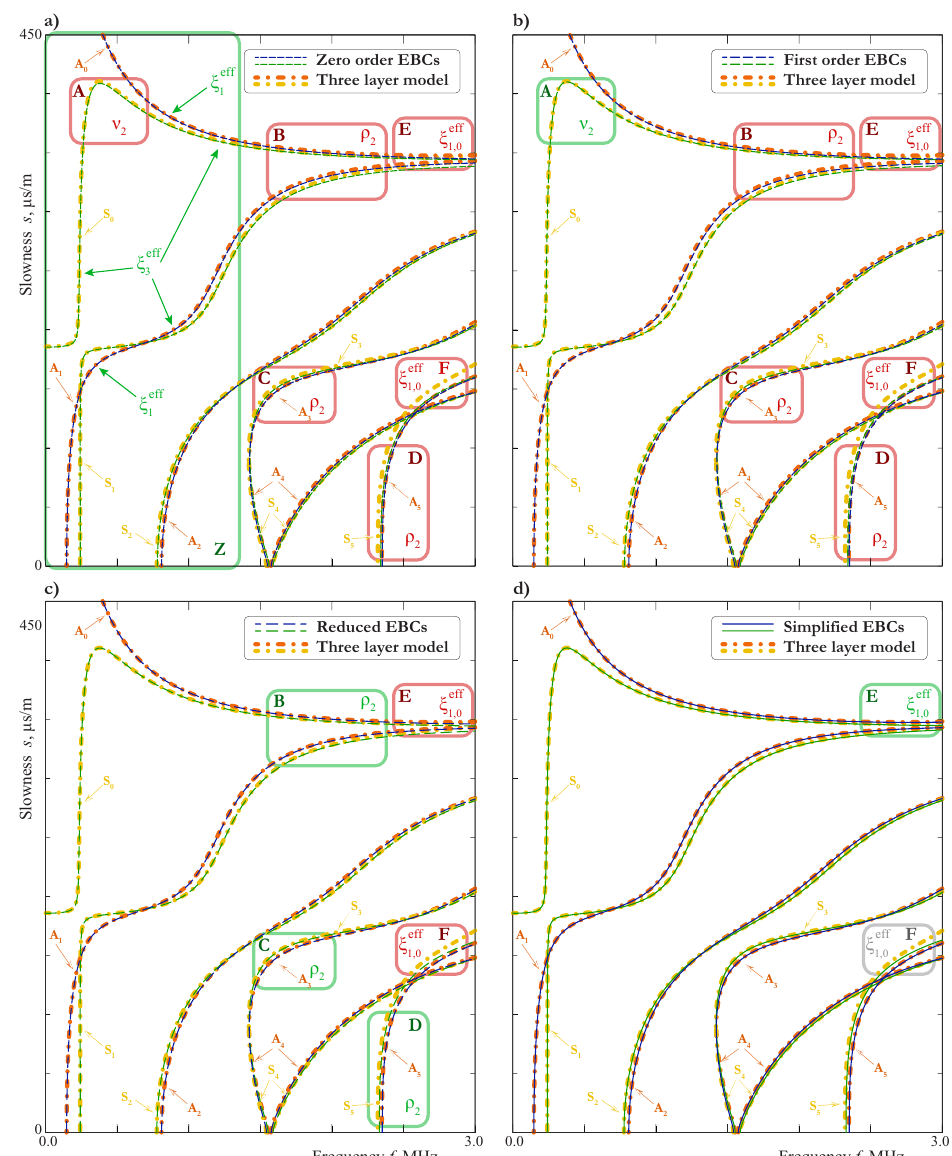
Figure 13. Slownesses of LWs propagating in 4.05 mm thickness plate (2 mm aluminium/50 µ m film/2 mm aluminium) with an imperfect contact at the interfaces ( κ 1 = κ 3 = 20GPa/mm) for different approximations of EBCs: ( a )—zero-order EBCs (48), ( b )—first order EBCs (47), ( c )—reduced EBCs (46), ( d )—simplified EBCs (44) and